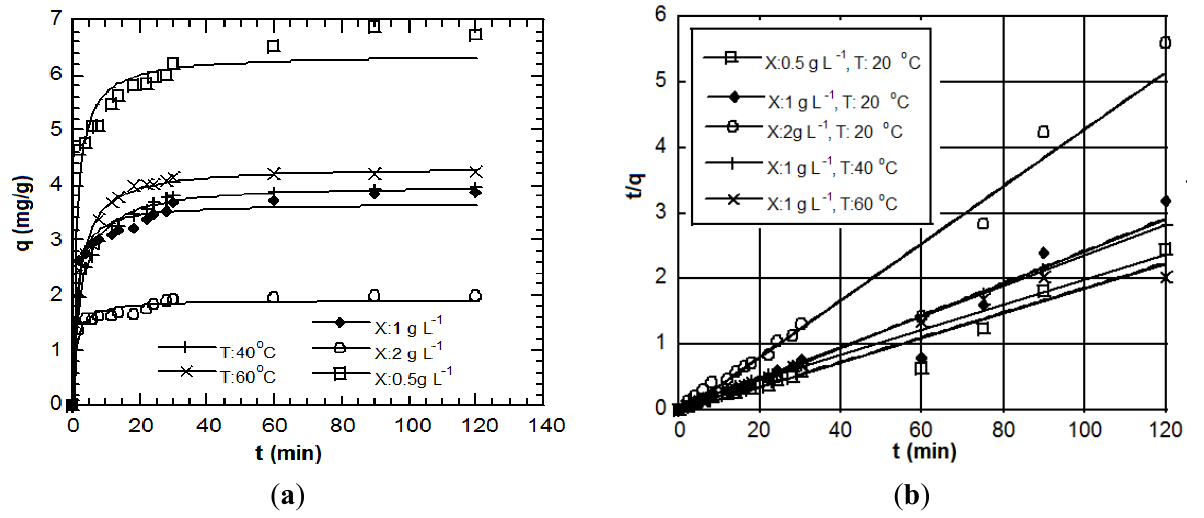
Figure 4. Comparison of experimental removal curves against theoretical predictions based: ( a ) on the Ritchie 2nd order equation (at initial cadmium concentration of 5 mg·L − 1 ) and ( b ) on the pseudo 2nd order equation (at initial cadmium concentration of 50 mg·L − 1 ). Reprinted with permission from reference [94]; copyright (2005) Taylor &